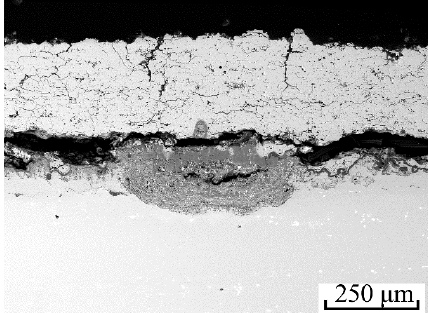
Fig. 43 Delamination cracks in TBCs depended on the mixed oxides. Reproduced with permission from